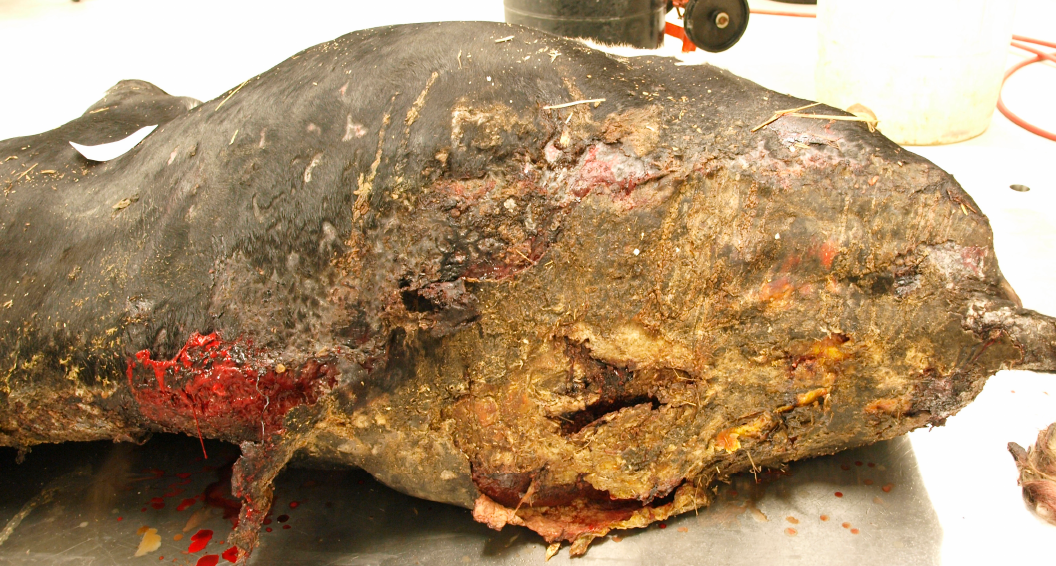
Figure 7. Holstein heifer with third degree burns to dorsum one month following a barn fire.